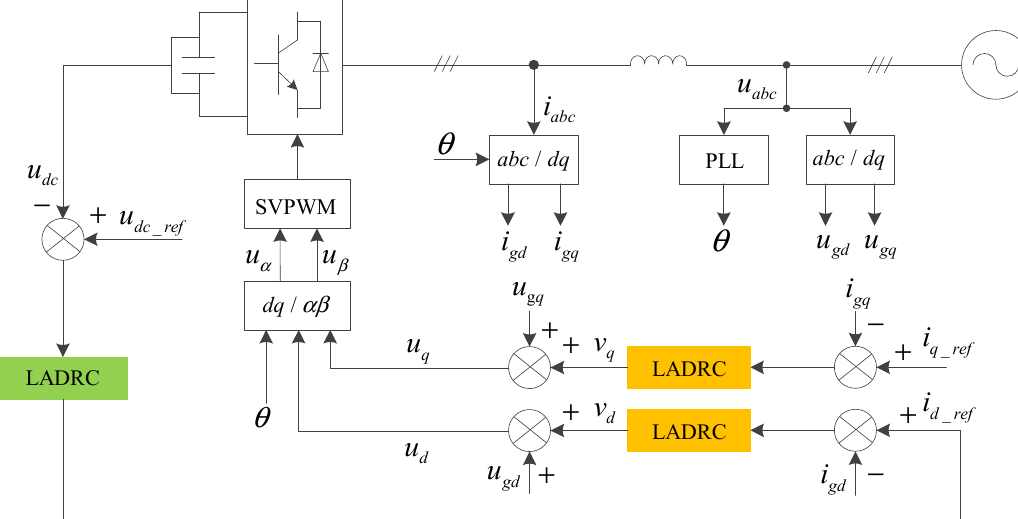
Figure 8. General structure diagram of grid-connected inverter control system.